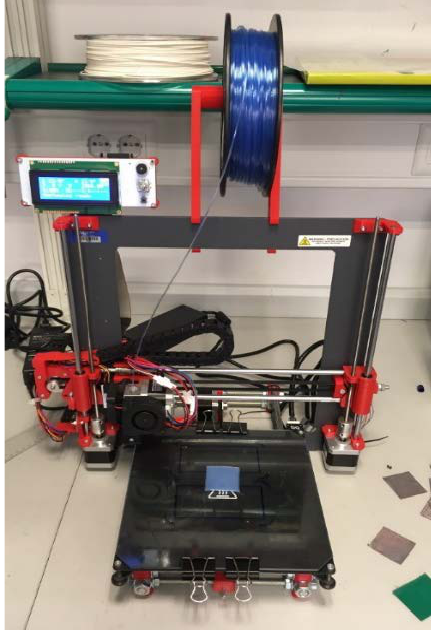
Figure 1. Prusa i3 BQ Hephestos 3D Printer used in this work. (Photo from BQ Hephestos).